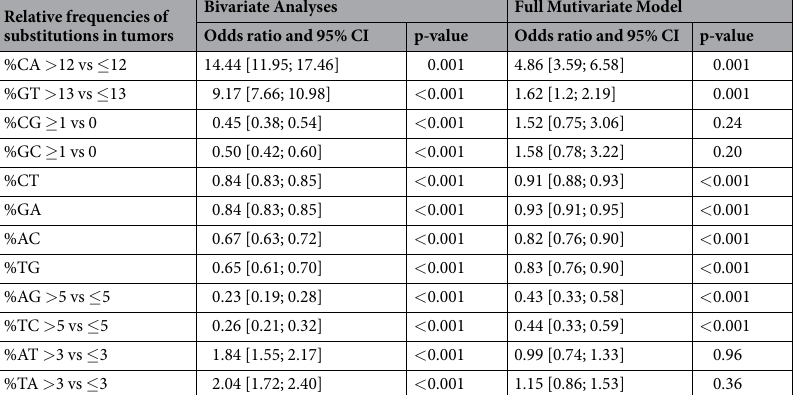
Table 2. Bivariate analysis and full multivariate model with the 12 substitution classes using logistic regression for the 4,908 tumors with a somatic substitution prevalence of ≥ 1 sub/Mb. CI = confidence interval; vs = versus; %CA = relative frequency of C > A substitutions (%); %GT = relative frequency of G > T substitutions (%); %CG = relative frequency of C > G substitutions (%); %GC = relative frequency of G > C substitutions (%); %CT = relative frequency of C > T substitutions (%); %GA = relative frequency of G > A substitutions (%); %AC = relative frequency of A > C substitutions (%); %TG = relative frequency of T > G substitutions (%); %AG = relative frequency of A > G substitutions (%); %TC = relative frequency of T > C substitutions (%); %AT = relative frequency of A > T substitutions (%); %TA = relative frequency of T > A substitutions